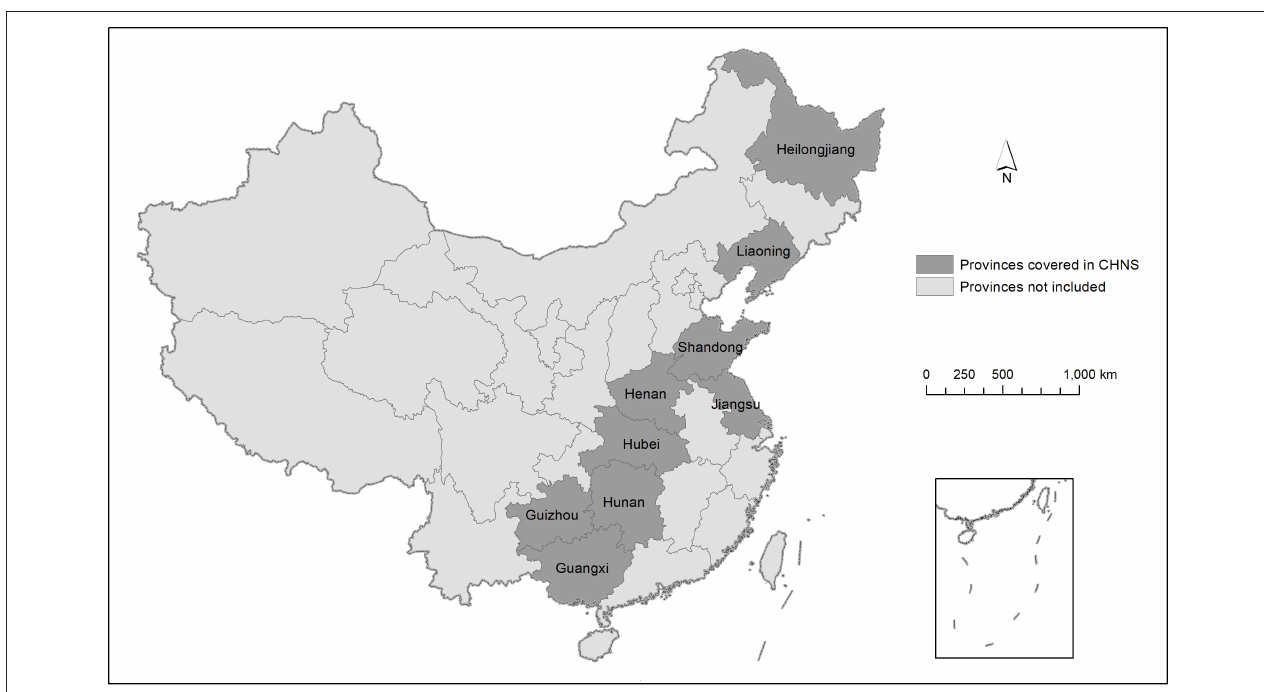
FIGURE 3 | Provinces covered in the China Health and Nutrition Survey